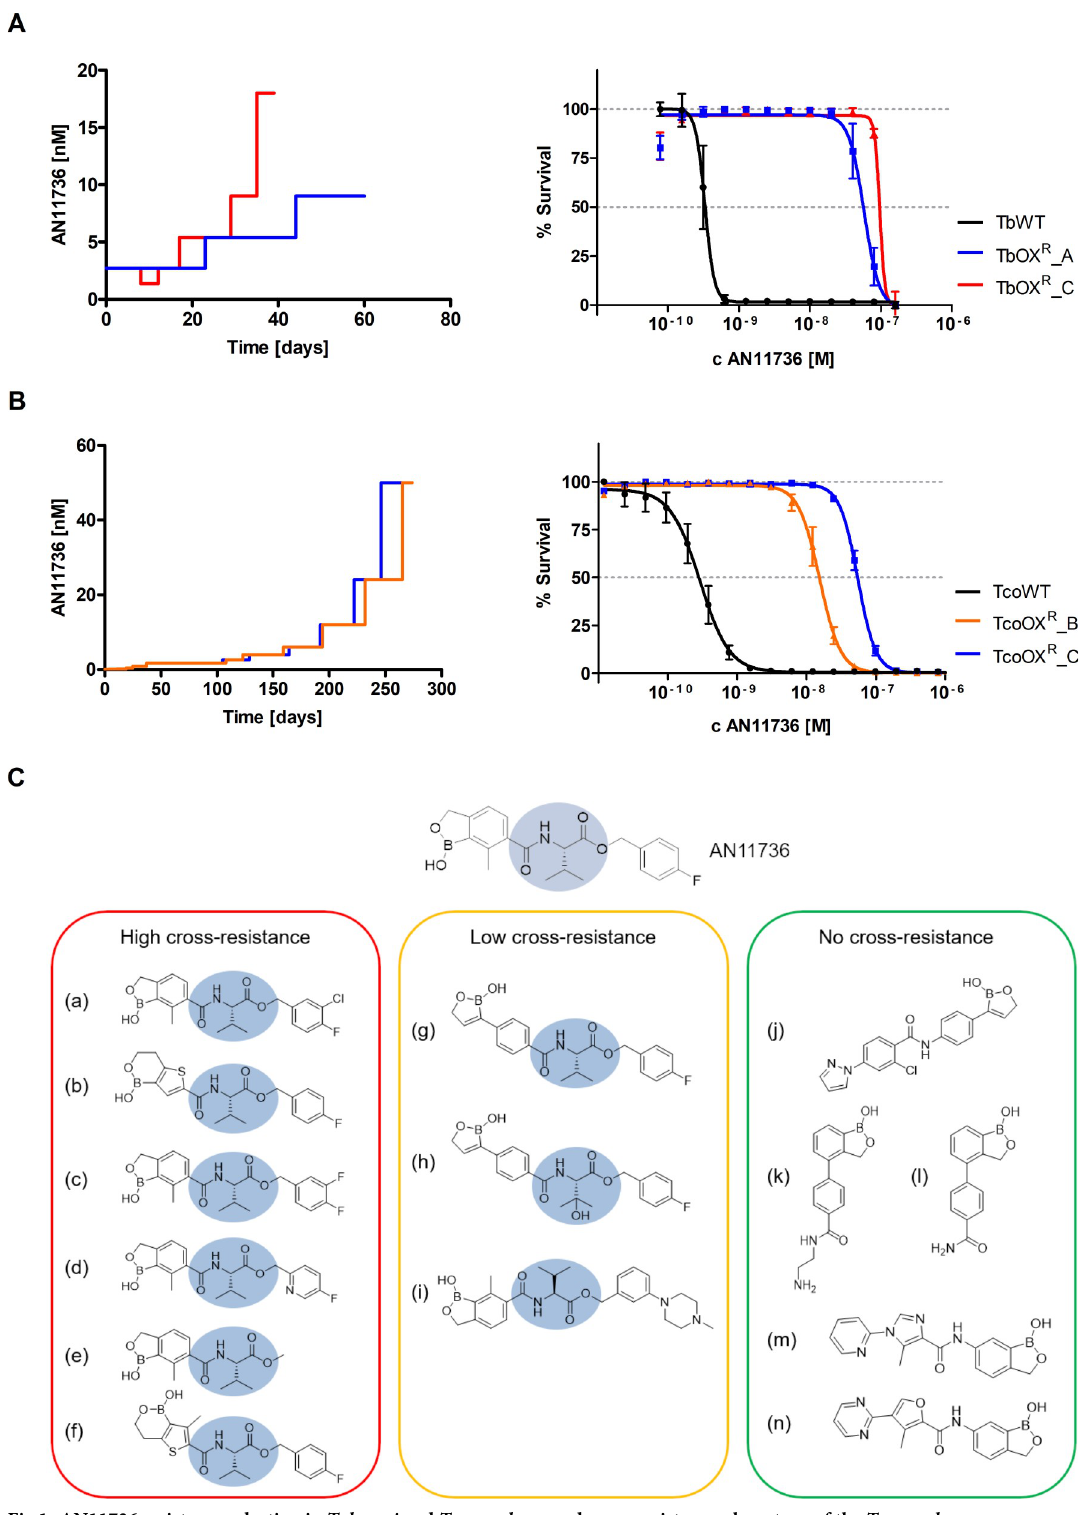
Fig 1. AN11736 resistance selection in T . brucei and T . congolense and cross-resistance phenotype of the T . congolense AN11736-resistant clones, revealing a common chemical feature. (A) In vitro selection of resistance to AN11736 in independent T . brucei lines TbOX R _A and TbOX R _C (left) and resistance levels of two resistant clones obtained from lines TbOX R _A (EC 50 58 nM)